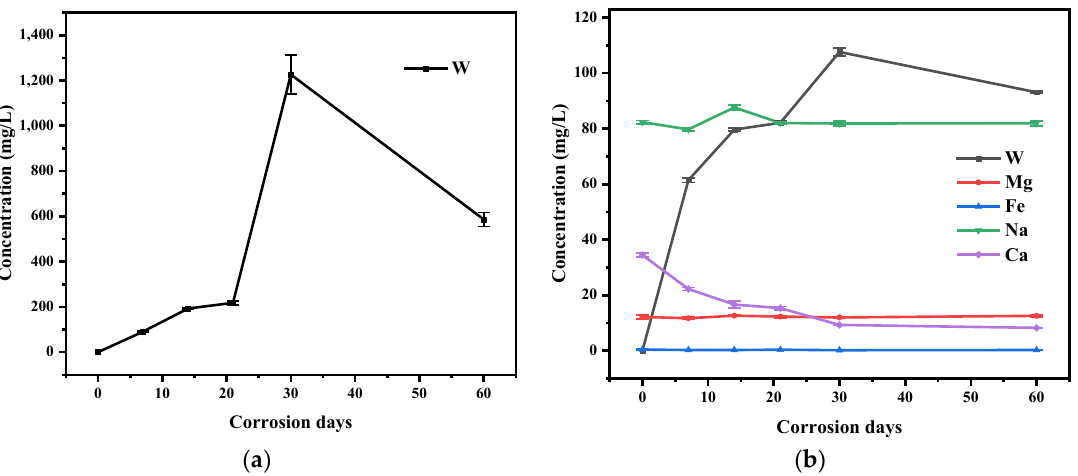
Figure 1. Changes in element concentration of ( a ) tungsten in ultrapure water and ( b ) tungsten in tap water for various corrosion days.